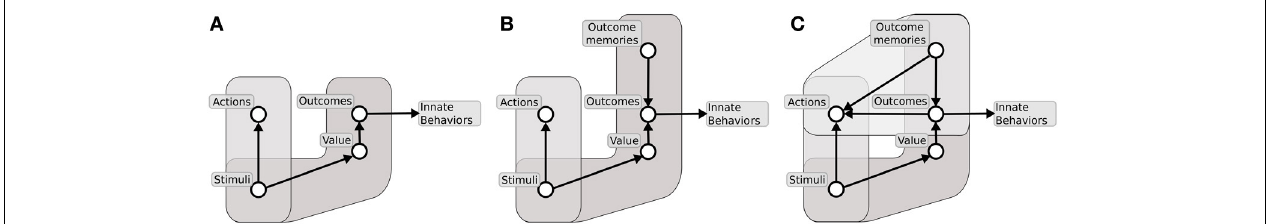
FIGURE 9 | The three major systems for learning to select desired outcomes forming an evolutionary lineage used here as a background for our hypothesis. (A) First system formed by instrumental stimulus-response behaviors and simple Pavlovian processes. (B) Second system formed by instrumental stimulus-response behaviors and